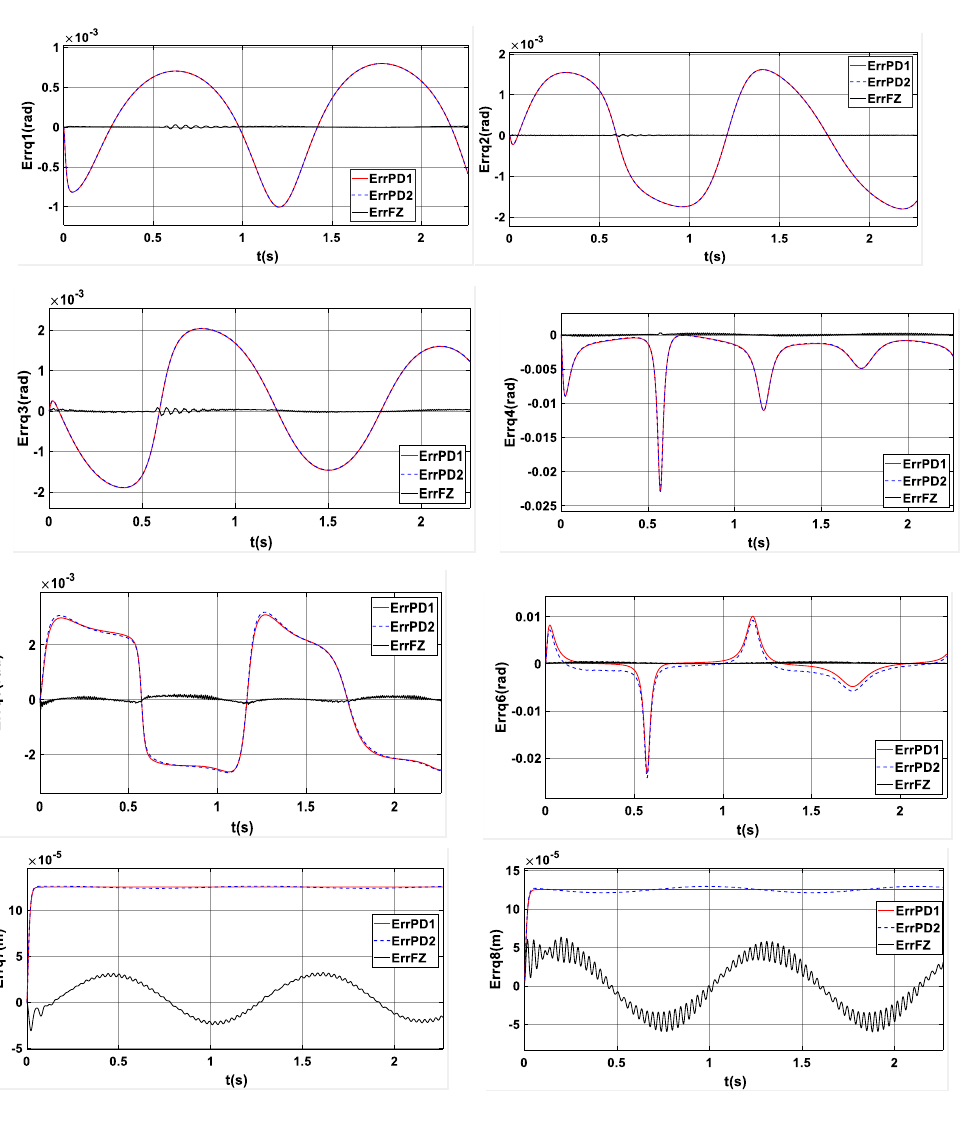
Figure 14. The errors of the cutting trajectory with respect to the set one are the toolpaths of the PD1, PD2, FZ controllers. One can see that the joint position errors of the fuzzy controller are smaller than that of the PD1 and PD2 controllers. Figure 15(a) shows the trajectory of the cutting point of the tool in the operational frame. Due to small errors, the desired and actual trajectories of the fuzzy controller and Inverse Dynamics + PD controller are approximately coinciding.